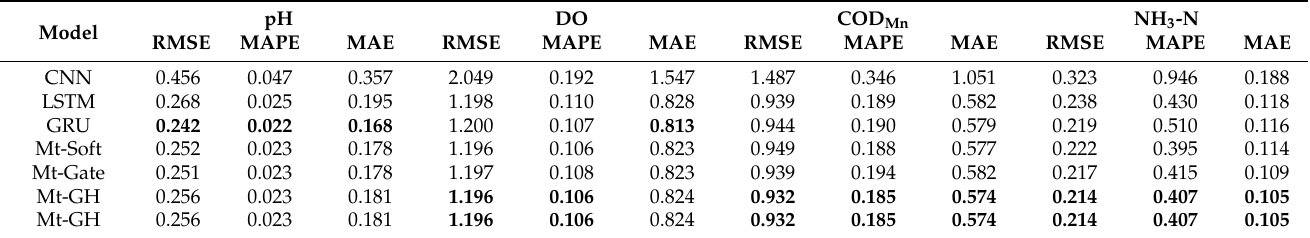
Table 4. Comparison of the overall performance of prediction for single-indicator on D-l dataset.